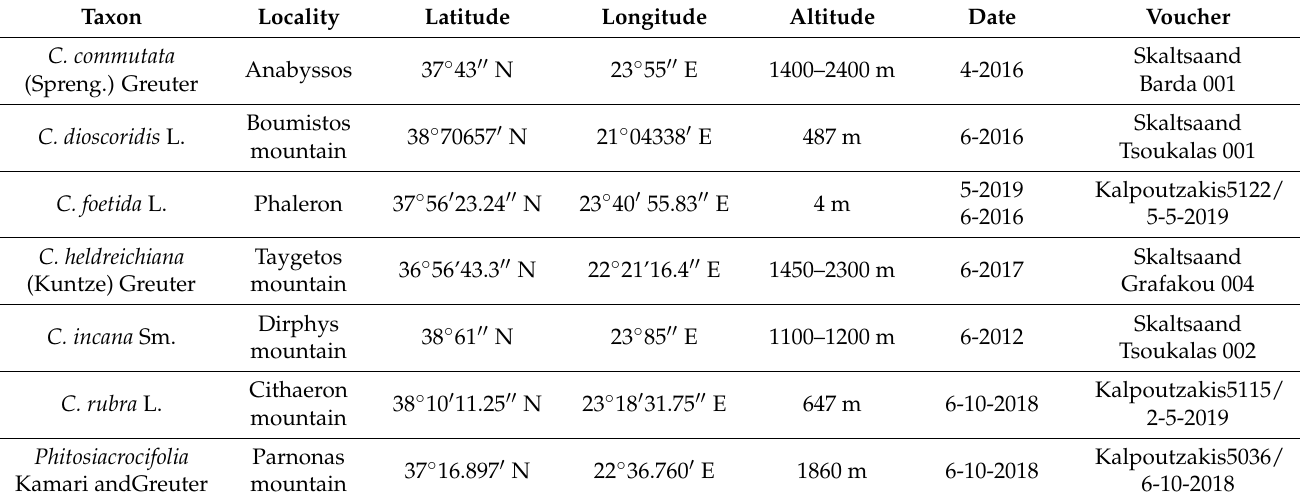
Table 7. Collection data of the investigated Crepis